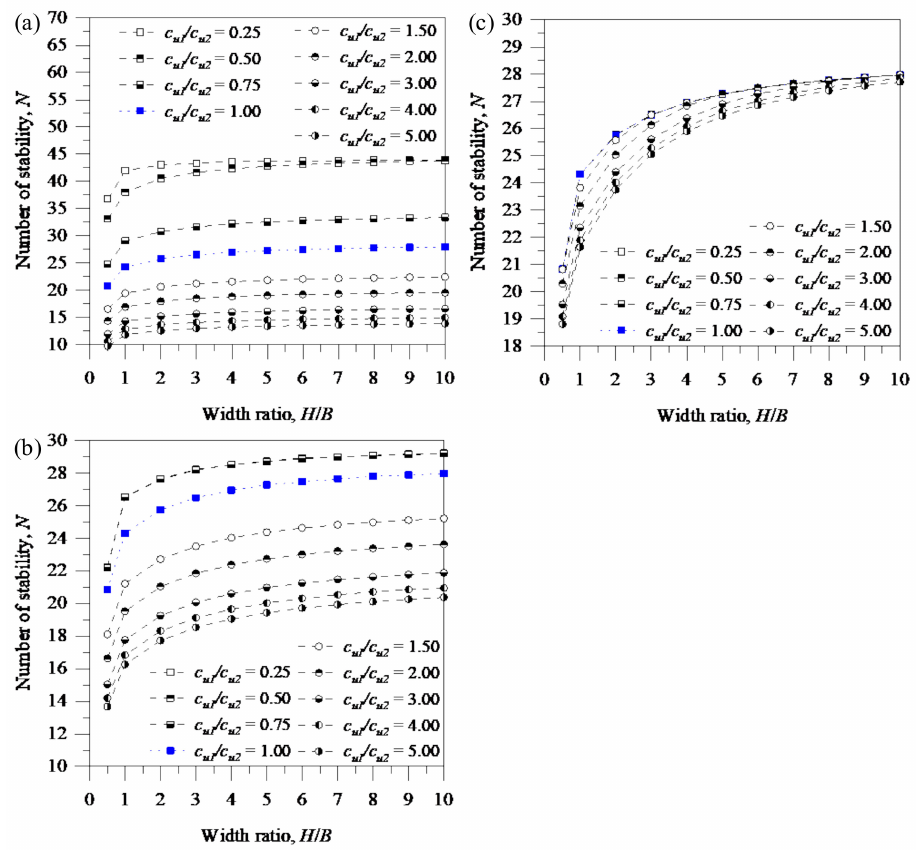
Figure 12. The e ff ect of the width ratio on the stability numbers, where T / H = 2, β = 30 ◦ , ( a ) D / H = 0.5, ( b ) D / H = 1.0, and ( c ) D / H =